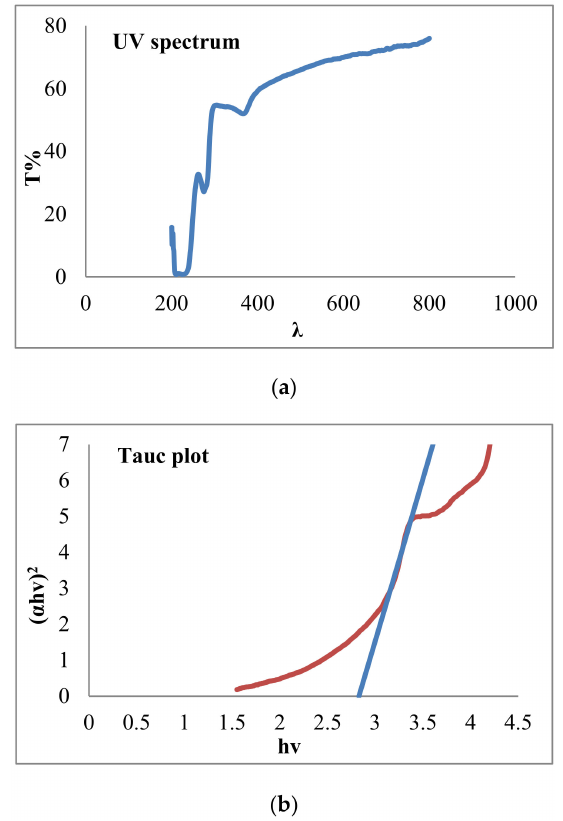
where a is the absorption coefficient, and h ν and E g are the photon energy and bandgap energy, respectively. Both measurements are in eVs. A 0 and 2 are the constants that depend on the type of electron transition [23]. As Figure 4b shows, the bandgap reduced from 3.3 to 2.89 electron volts. This result indicated that the optical property of ZnO improved with doping neodymium nitrate.